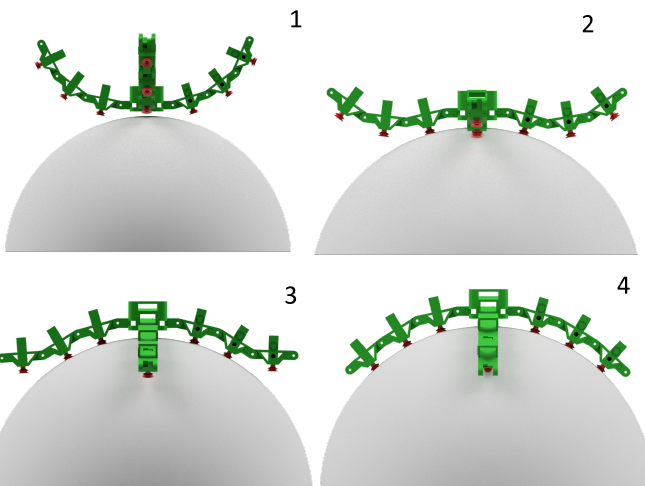
Figure 2. Example of sequential closure with a sphere having a radius four times the phalanx